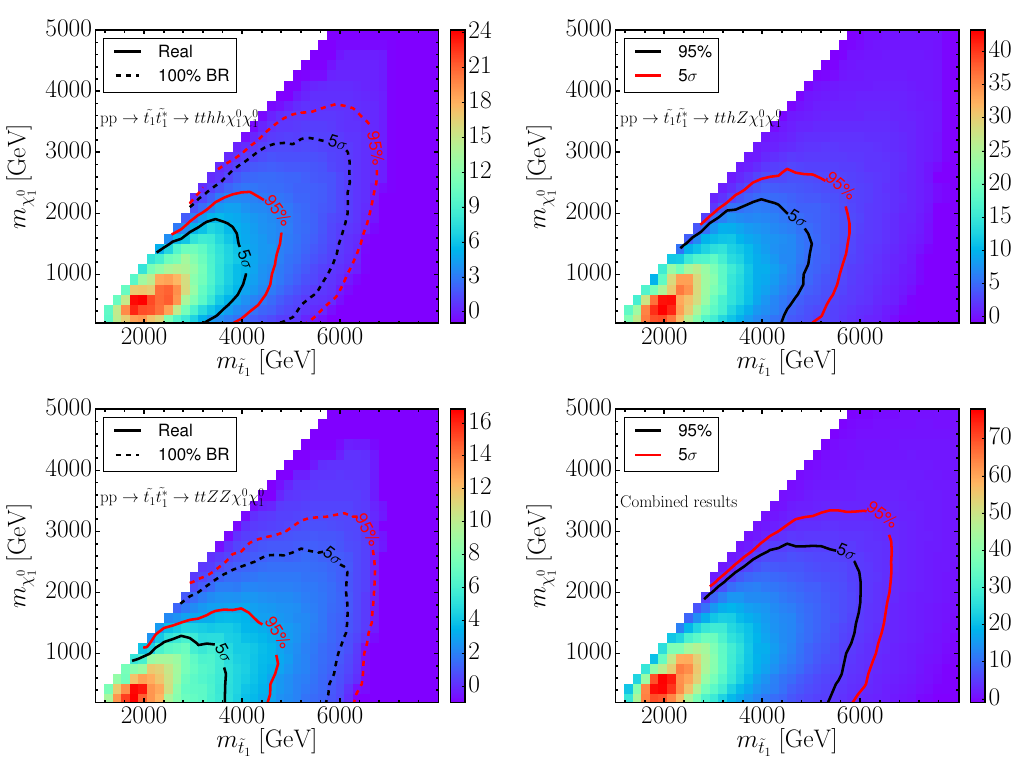
Figure 10 . The 95% CL upper limits (black curve) and 5 (cid:27) discovery reach (red curve) are shown in the plane of MSSM parameter space m ~ vs m for the stop pair production pp (cid:31) 0 1 t 1 t (cid:22) t(cid:31) 0 =(cid:31) 0 t (cid:22) thh E E E (top left), t (cid:22) thZ (top right), t (cid:22) tZZ (bottom left) and combined channels T T T 2 3 ! 6 6 6 (bottom right) at 100 TeV future pp collider with 3000 fb (cid:0) 1 integrated luminosity for region. (cid:22) is (cid:12)xed to be M 1 + 500 GeV and 10% systematic uncertainties are assumed. Solid line stands for the realistic MSSM scenario and dotted line represents the simpli(cid:12)ed model assuming a 100% decay branching fraction. The color coding on the right indicates the signal signi(cid:12)cance to guide the eye.